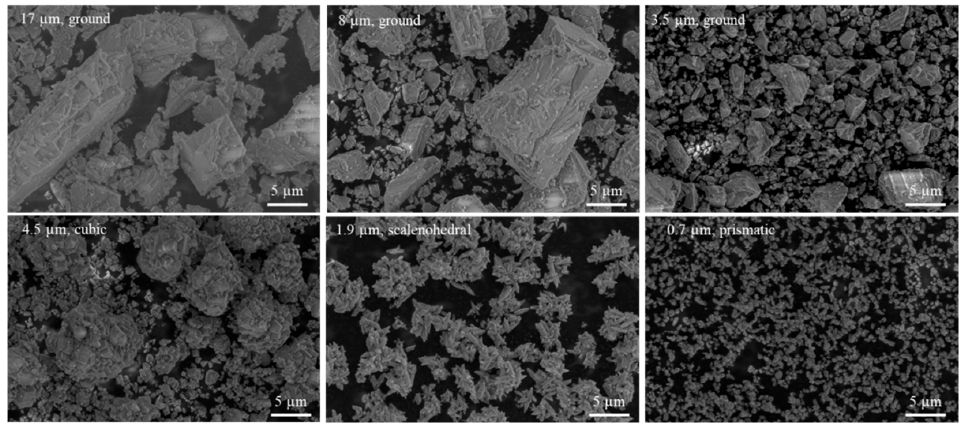
Figure 3. ESEM images of CaCO 3 as-received powder to confirm particle shape and size prior to compounding.